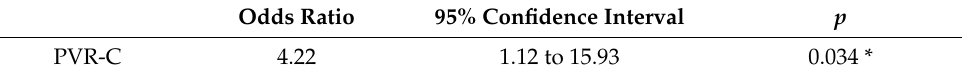
Table 5. Risk for surgical failures (levels 2 or 3) in the propensity-score matched population.